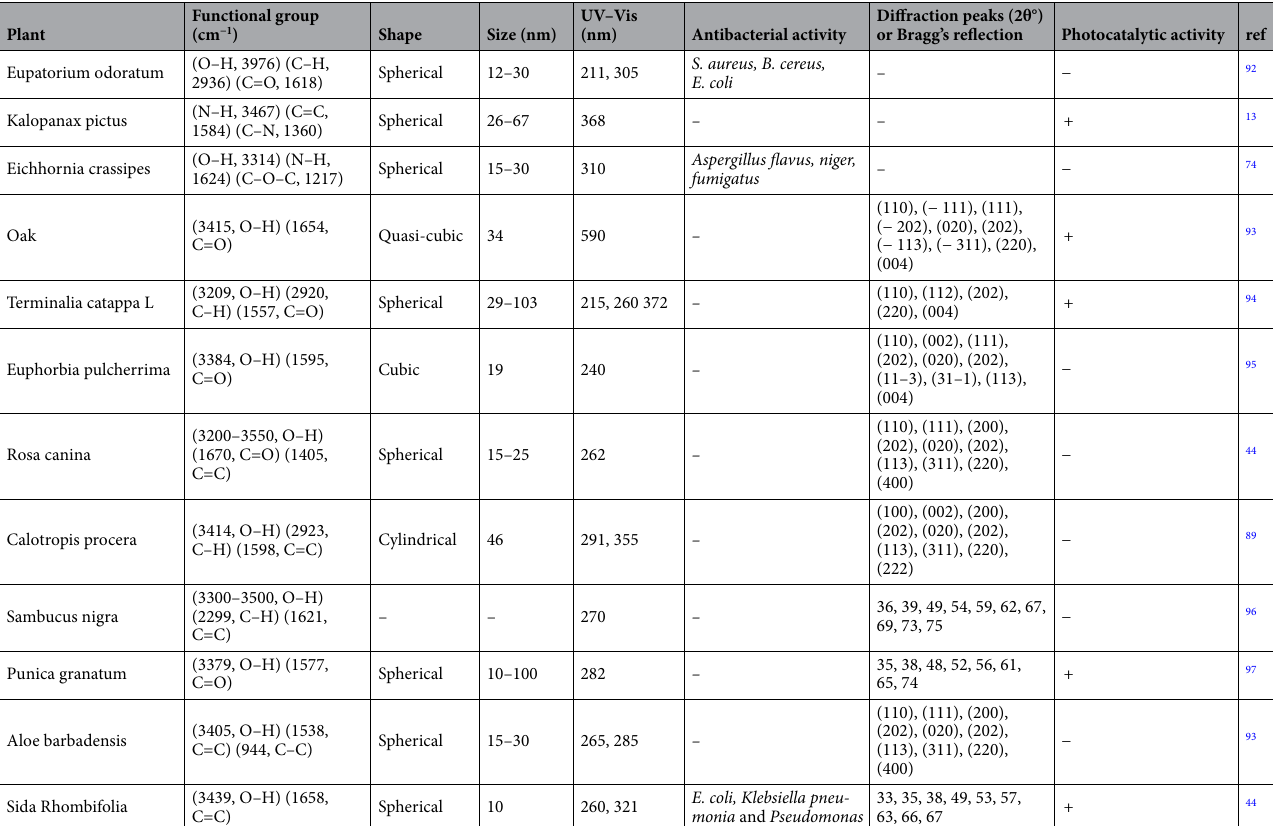
Table 2. The survey on the recent advancements on the biomedical potentials of the CuO nanoparticles. “− “ and “+ ” represent the absence and presence of the